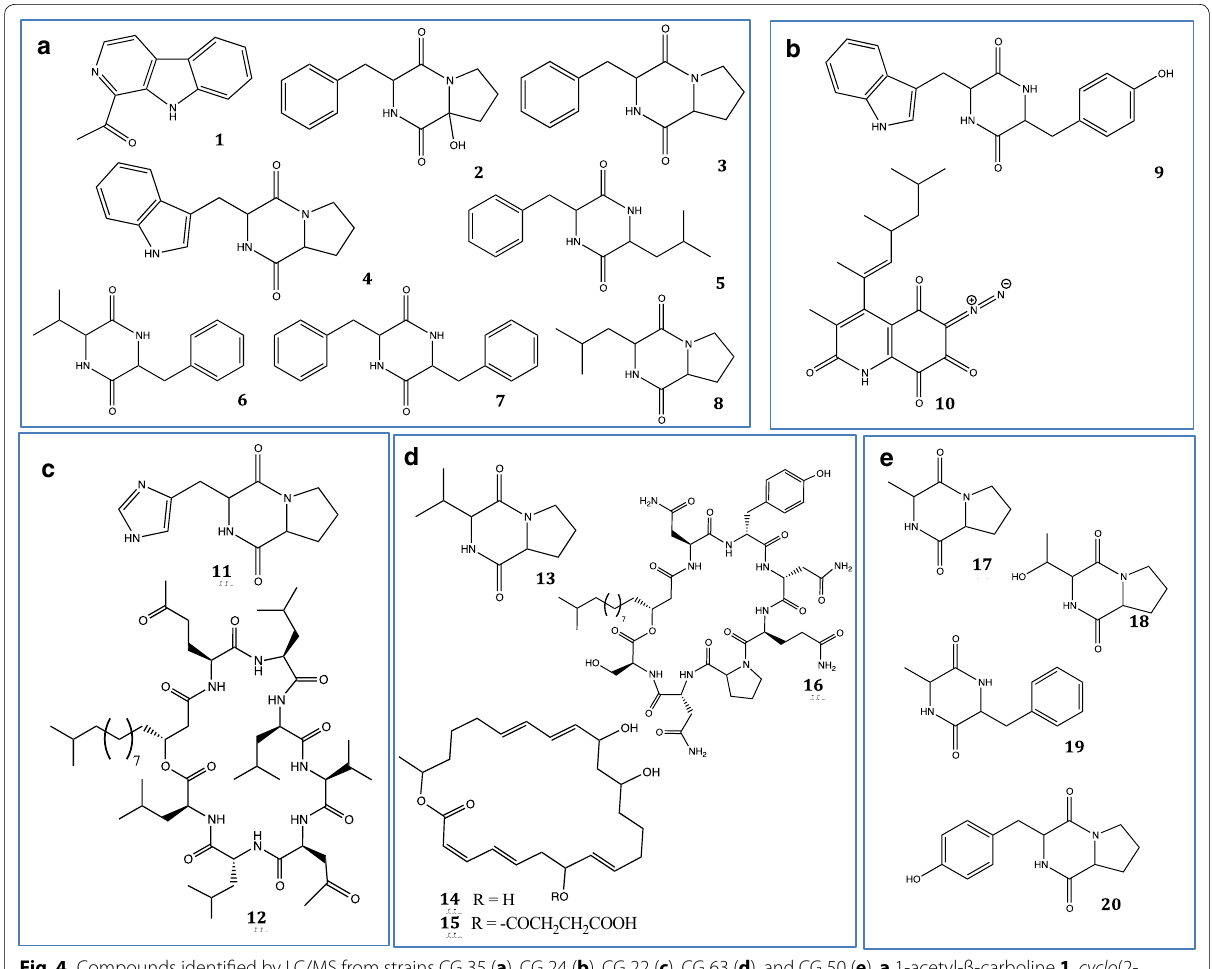
Fig. 4 Compounds identified by LC/MS from strains CG 35 ( a ), CG 24 ( b ), CG 22 ( c ), CG 63 ( d ), and CG 50 ( e ). a 1‑acetyl‑β‑carboline 1 , cyclo (2‑ OHPro‑Phe) 2 , cyclo (Pro‑Phe) 3 , brevianamide F 4 , cyclo (Leu‑Phe) 5 , cyclo (Val‑Phe) 6 , and cyclo (Phe‑Phe) 7 , cyclo (Pro‑Leu) 8 ; b cyclo (Trp‑Tyr), lagunamycin 10 ; c cyclo (His‑Pro) 11 ; Surfactin 12 ; d cyclo (Pro‑Val) 13 , macrolactin 14 , succinoylmacrolactin 15 , and iturin 16 ; e cyclo (Pro‑Ala) 17 , cyclo (Pro‑Thr) 18 , cyclo (Ala‑Phe) 19 , cyclo (Pro‑Tyr)